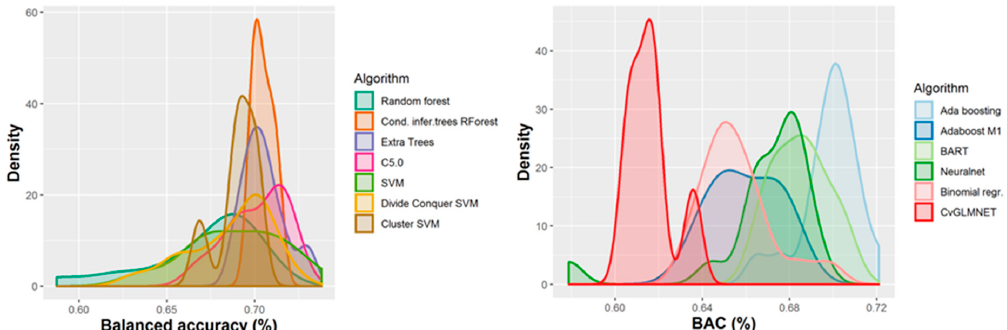
Figure 6. Performance of 165 QSAR models in terms of balanced accuracy.